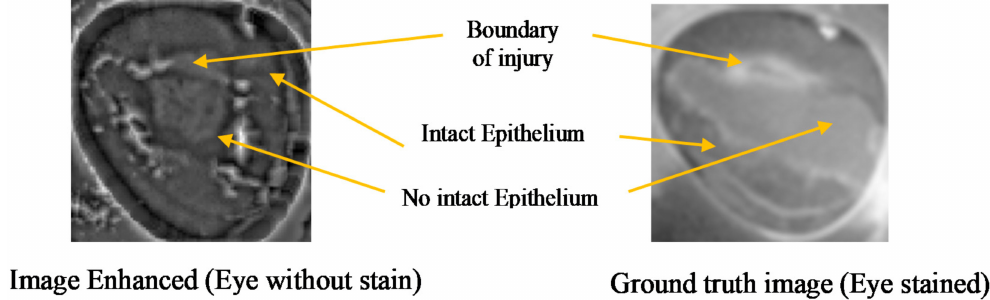
Figure 15. Image enhanced and ground truth